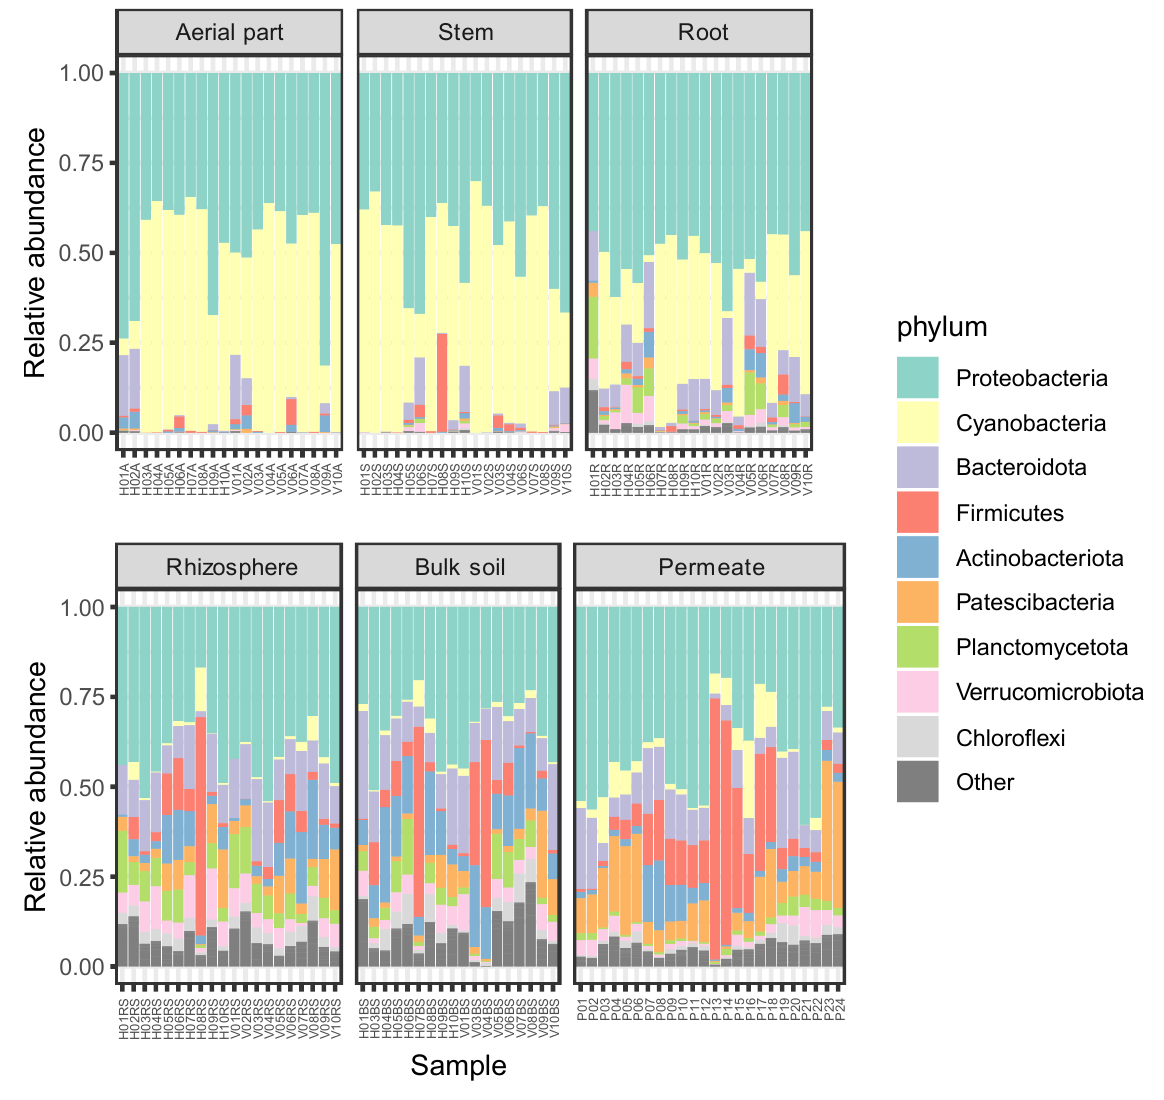
Figure 3. Relative abundances of bacterial phyla in each sample. ASVs representing < 5% of the whole community have been reported as “Other”.